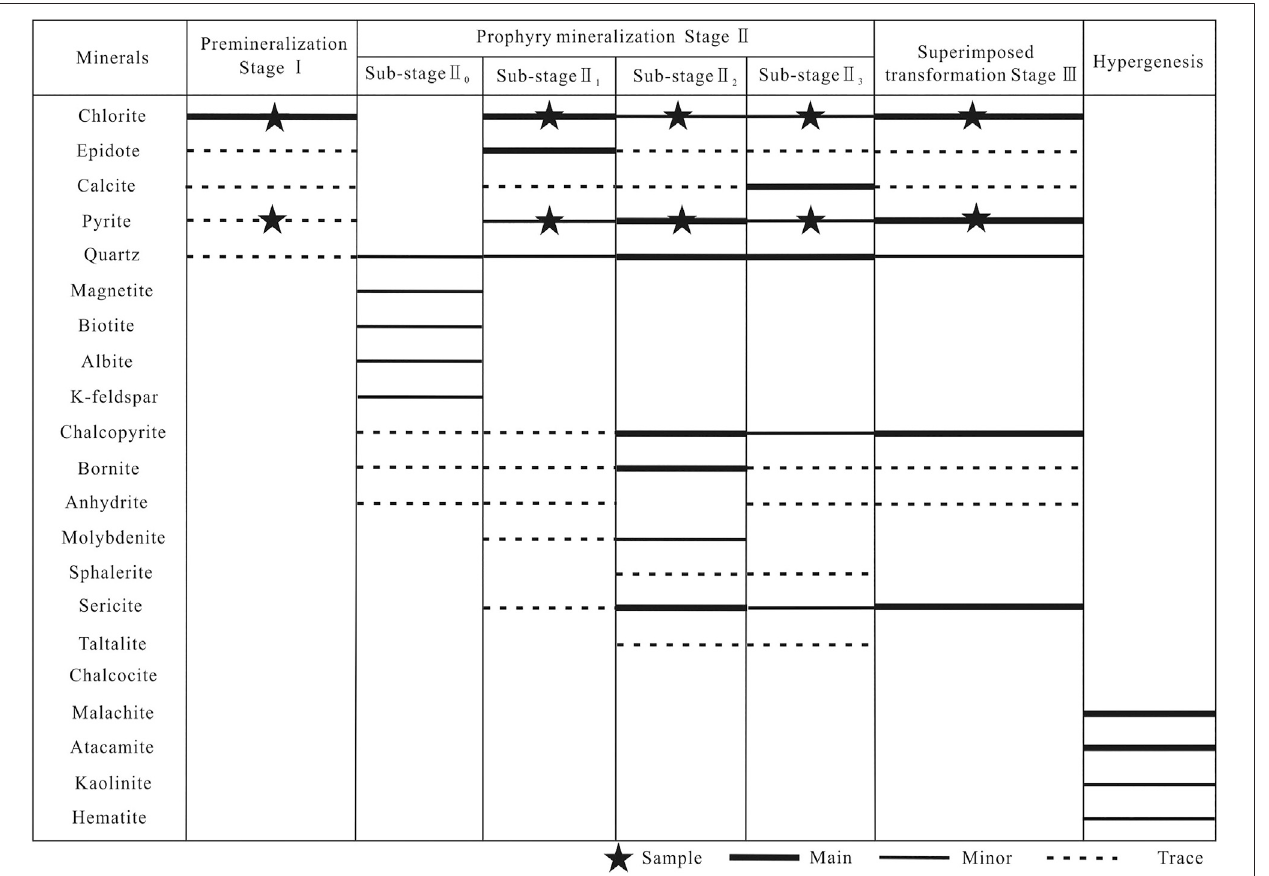
FIGURE 6 | Alteration and mineral time – space diagram for the paragenetic history of the Tuwu porphyry Cu deposit in eastern Tianshan, Xinjiang, NW China.